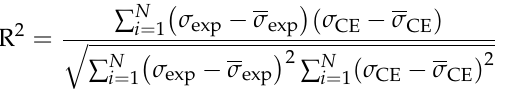
Figure 11. Arrhenius modeling results from the experimental data at different temperatures and strain rates. ( a ) T = 950 °C; ( b ) T = 1000 °C; ( c ) T = 1050 °C; ( d ) T = 1100 °C.